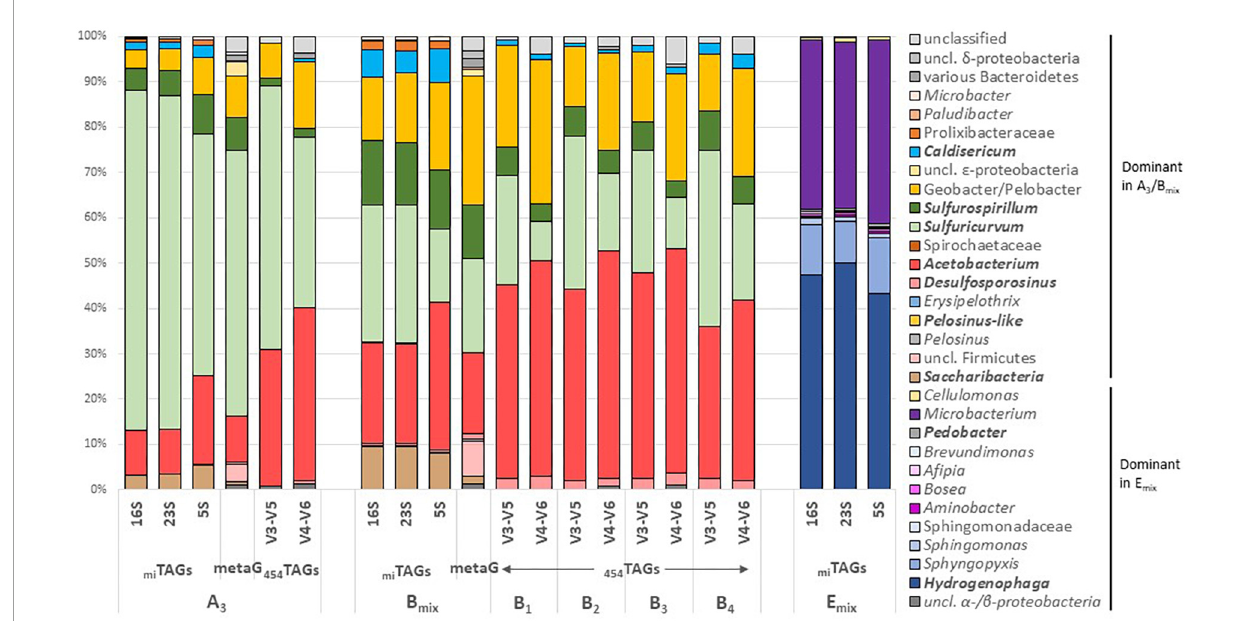
FIGURE1 Community structure of metagenomes A 3 , B mix , and E mix from East Skaftárkatlar lake based on metagenome extracted rDNA mi TAGs. Assignments were performed using BLASTN against SILVA 128 (Quast et al., 2012; Yilmaz et al., 2013).